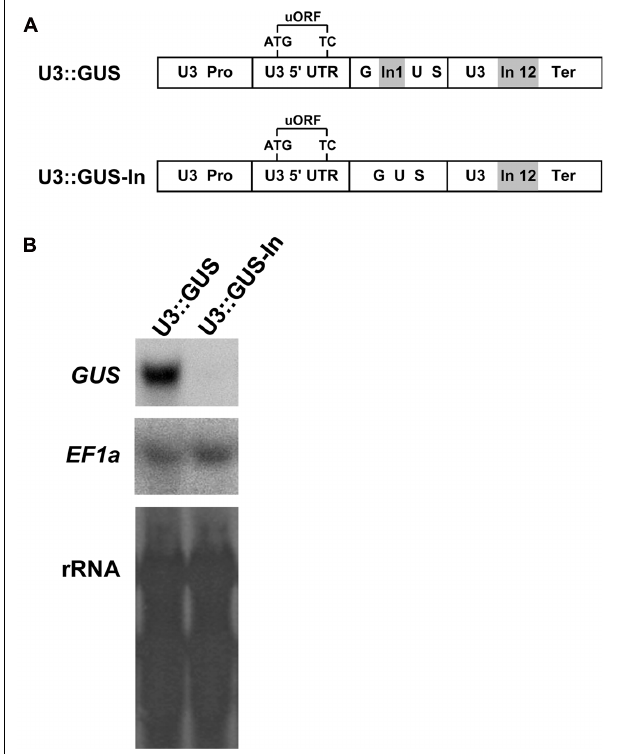
FIGURE 1 | The first intron of UPF3 is essential for its expression. (A) The constructs used for expression analysis. The U3::GUS construct included the UPF3 promoter (U3 Pro), the 5 (cid:48) UTR of UPF3 (U3 5 (cid:48) UTR), which contains an upstream open reading frames (uORF), the coding sequence of β -glucuronidase (GUS), which includes the first intron of UPF3 (indicated by the letters In1 on gray background), and the terminator of UPF3 , which includes the 12th intron of this gene (indicated by the letters In12 on gray background). The terms ATG and TC refer to the initiation and termination codons, respectively, of the uORF. The fusion between GUS and the first intron is illustrated in Supplementary Figure 1B. The U3::GUS-In construct was identical to the U3::GUS construct, except that it did not include the first intron of UPF3 . (B) Northern blot hybridization of RNA extracted from Arabidopsis (Col-0) plants expressing the constructs illustrated in (A) with the GUS or EF1a gene probes. The figure shows a representative pair from the 20 biological replicates that were hybridized for each construct. For each construct, RNA was extracted from 2-week-old plants grown in 20 plates (which constituted the 20 biological replicates). The 20 plates of each construct included a total of ∼ 1000 plants. These 1000 plants were germinated from mixtures including ∼ 40 T2 progeny plants from each of the 25 independent T1 transformants regenerated for each construct. The corresponding methylene blue staining of the ribosomal RNA (rRNA) is shown below the